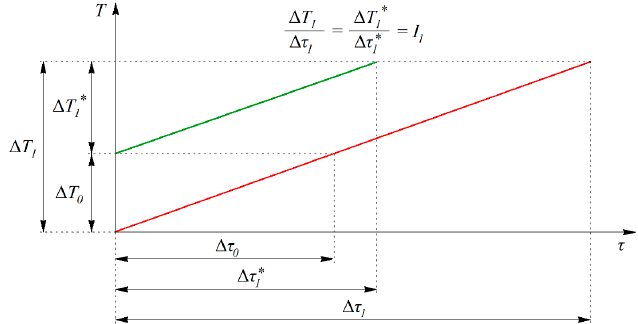
Figure 3. Dependence of the first heating stage in variations of the initial temperature ( T 0 * > T 0 ) at a given heating intensity ( I 1 = const). The deceleration of the furnace cooling by a gradual decrease in electrical power is usually not required [53]. It was possible to reduce the auxiliary time for loading and un- loading operations the furnace in the full working cycle of ceramic production using fur- naces of the European brand Nabertherm (Table 3). The furnaces used more effectively